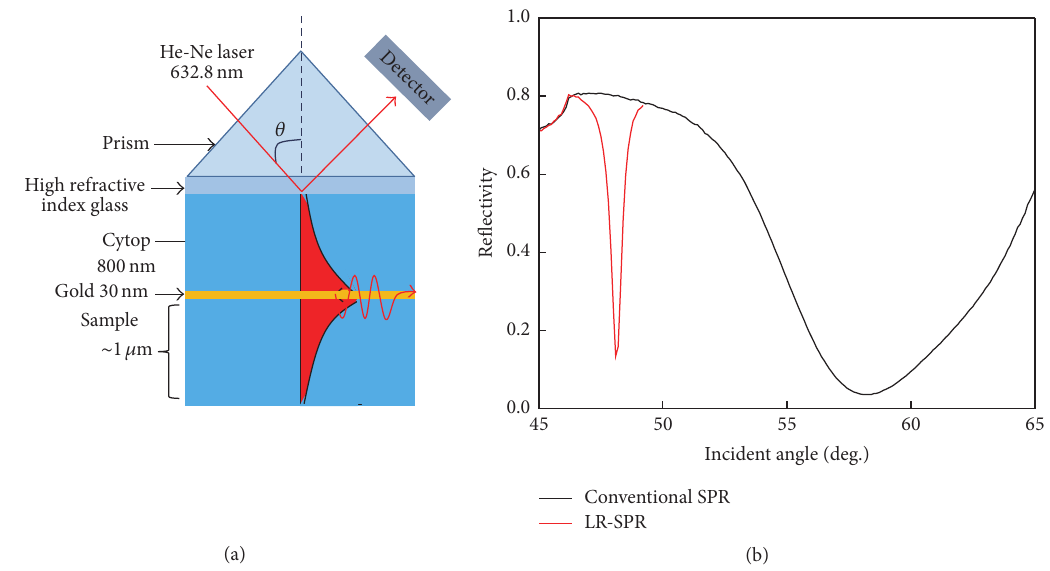
Figure 1: (a) Schematic of the long-range surface plasmon resonance (LR-SPR) setup. (b) The angular reflectivity curves of conventional SPR (prism-glass slide/gold (50 nm)/PBS buffer) and LR-SPR (prism-glass slide/Cytop (800nm)/gold (30 nm)/PBS